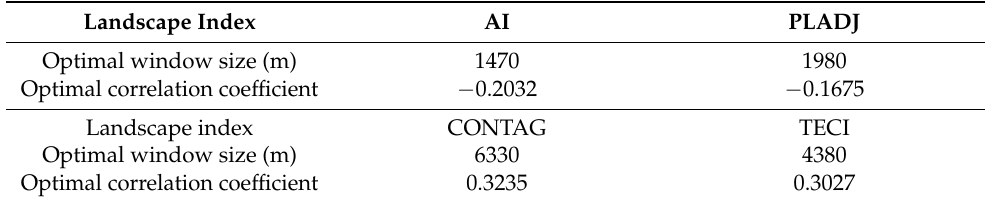
Table 8. The optimal window of Gaussian landscape index. Landscape